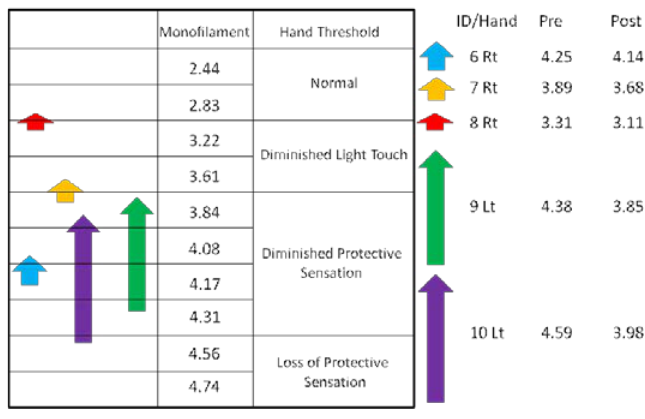
Fig. 10. “With glove” average changes for each of the five hands, illustrated on a sensation threshold scale. Figs. 7 and 8, “without glove” and “with glove,” respectively, depict the changes from pre to post training for the between subject study. Figs. 9 and 10 present the pre